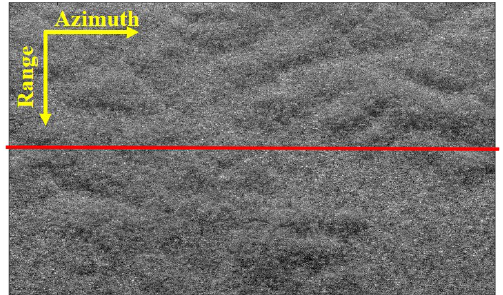
Figure 14. The SAR image of the forest area.